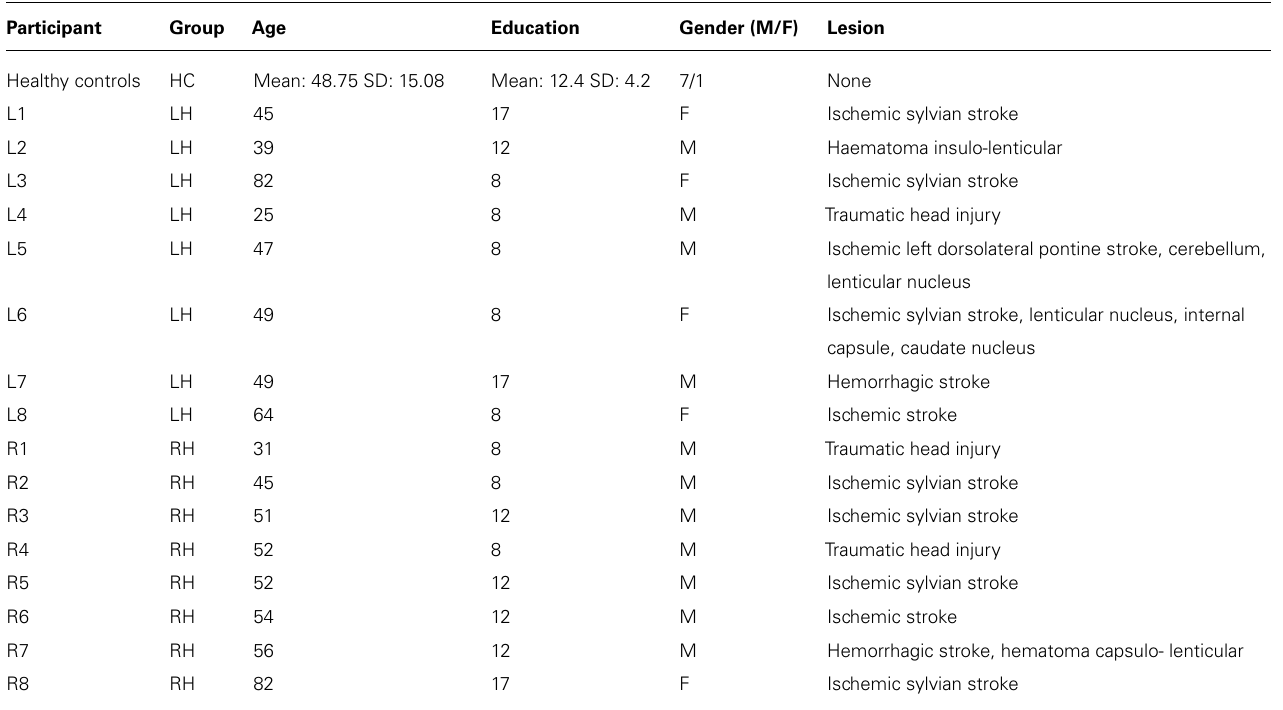
Table 1 | Demographical data of healthy controls (HC) as well as LH and RH patients.